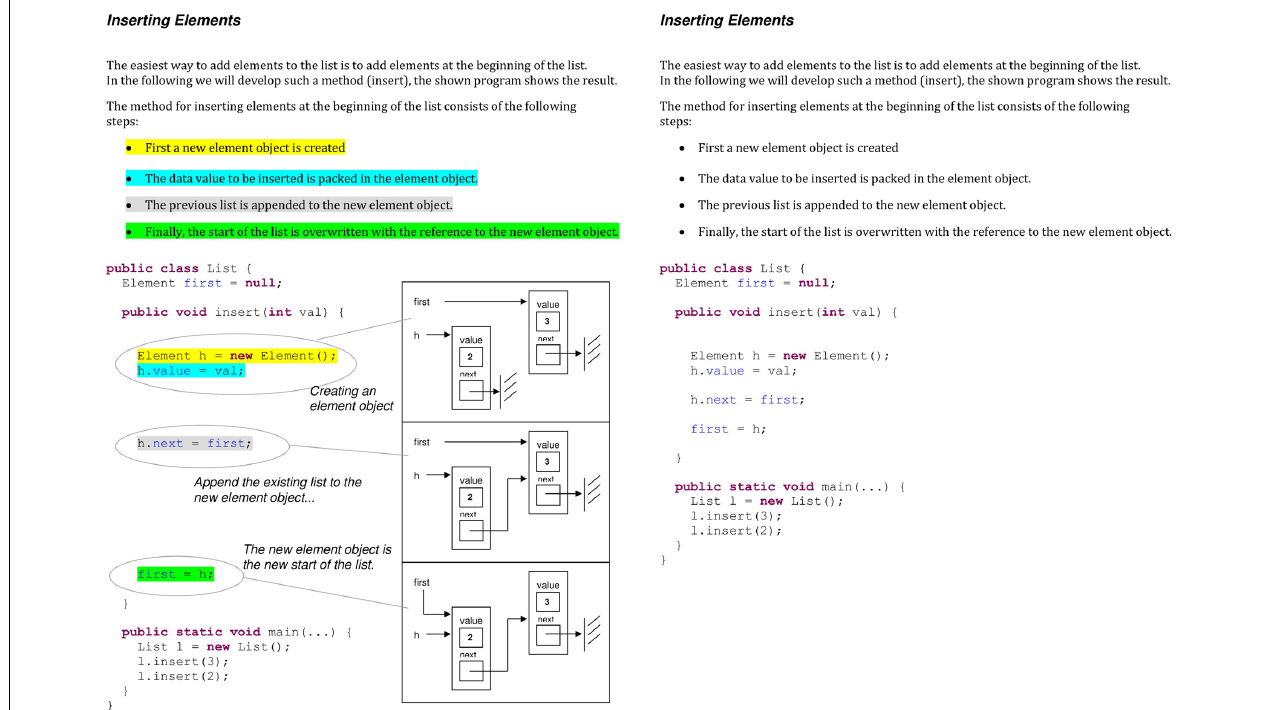
FIGURE 1 | Learning material including textual and graphical representations and signaling through color coding, lines and graphic annotations on the left side and no supporting elements on the right